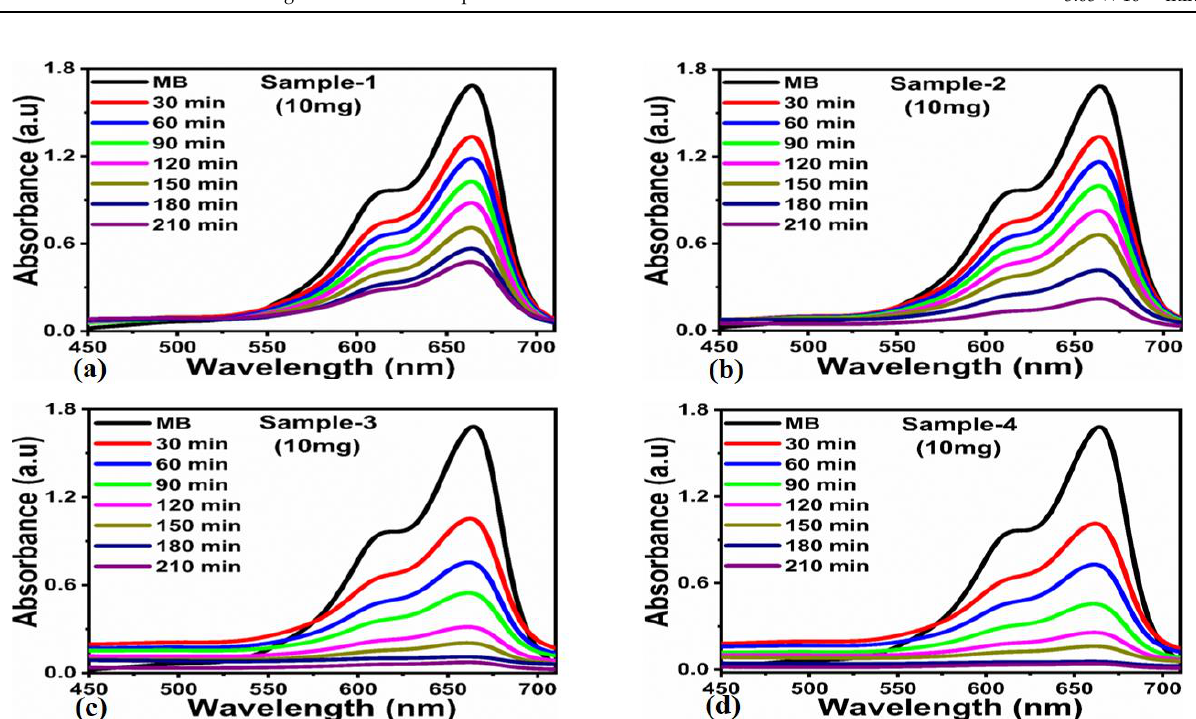
Figure 8. ( a – d ) UV-visible absorption spectra of photodegradation of 8.22 × 10 −5 M) MB solution using catalyst dose of 10 mg of different ZnO samples including sample-1, sample-2, sample-3, and sample-4.